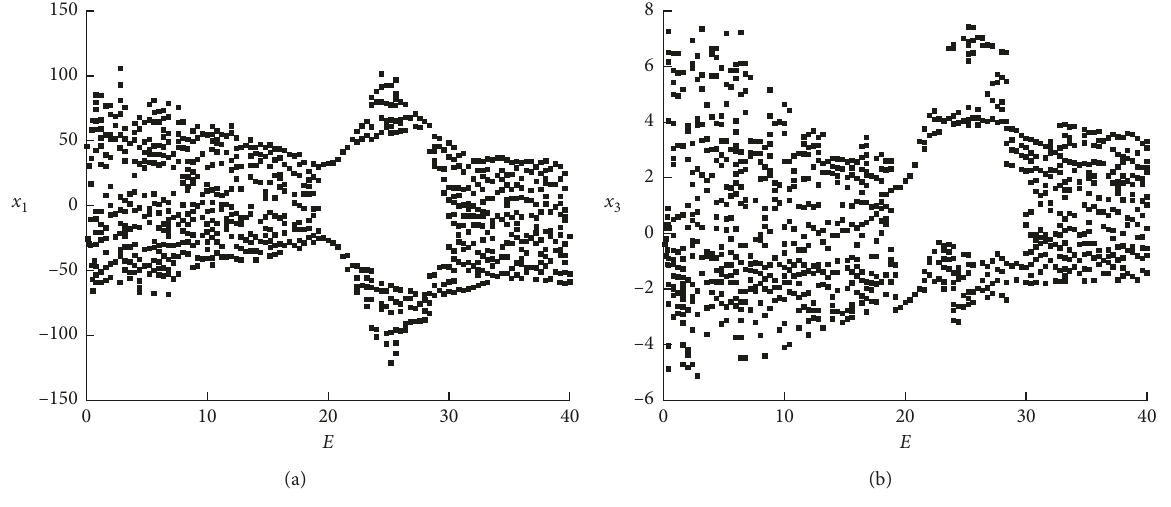
Figure 16: Bifurcation diagram of the composite shell with the electric field increase. (a) x